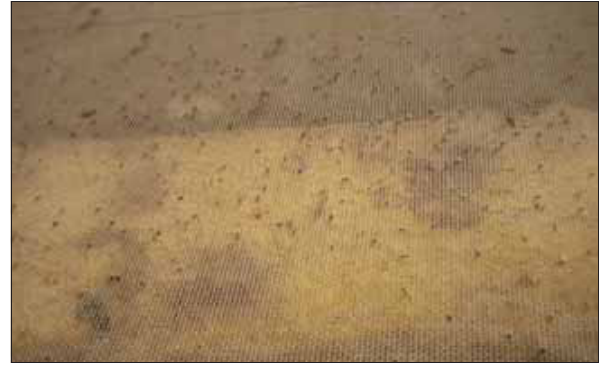
Figure-4: Netting prevented entry of Culicoides midges in the buffalo shed.